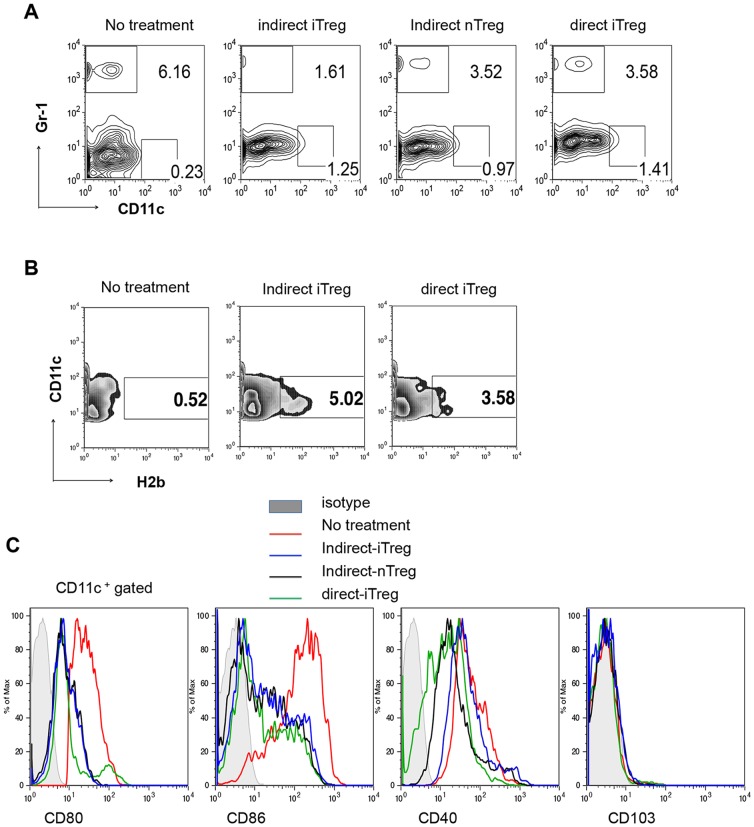
Analysis of DCs in the grafts.
A, Gr-1 and CD11c staining in cells filtrated in cardiac grafts 7 days after transplantation in mice with the indicated treatment. B, Population of CD11c+H2b+ cells in the filtrated cardiac graft cells. The graft undergoing no treatment was harvested 14 days after transplantation, and other 2 grafts were harvested 35–40 days after transplantation. C, Cell-surface marker expression of CD11c+ cells filtrated in the cardiac grafts 14 or 15 days after transplantation in mice tread with the indicated Tregs.